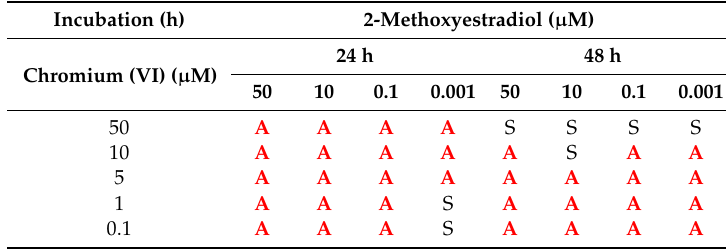
Table 2. Interpretation of the combined e ff ect of 2-methoxyestradiol and potassium chromate (VI) on SKOV-3 cells in the MTT assay after 24 h and 48 h of incubation, using the CompuSyn